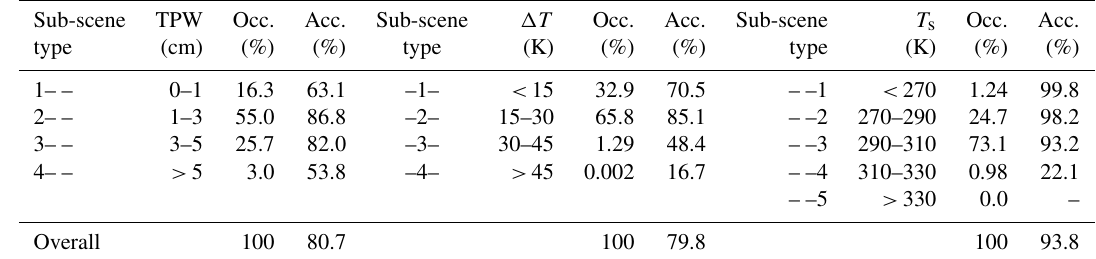
Table 3. Accuracy of the sub-scene type classification algorithm described in Sect. 3.2. The statistics are based on collocated nadir-view AIRS and CERES observations in 2004. “Occ.” and “Acc.” in the Table denote occurrence and accuracy, respectively. The sub-scene type is coded as a three-digit number. The first digit refers to TPW, the second one refers to (cid:49)T and the last refers to T s , as defined in the table. The definition of sub-scene types here is identical to the LW discrete intervals in Loeb et al. (2005). Occ.